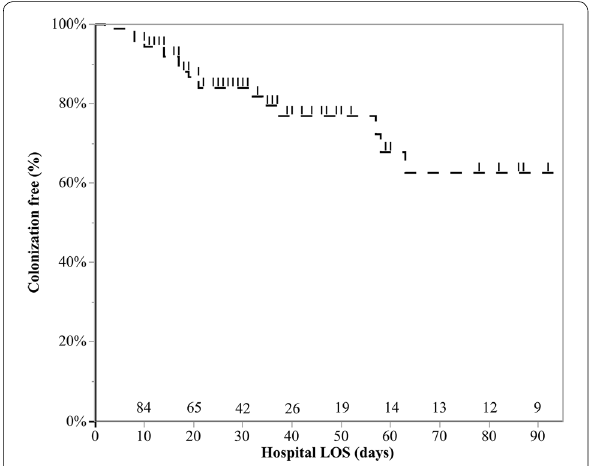
Fig. 2 Probability of being infection-free. Kaplan–Meier estimates of the unadjusted cumulative probability of being infection-free. Tracked line represent colonized patients, tick line represent non-colonized patients. Tick marks represent censored